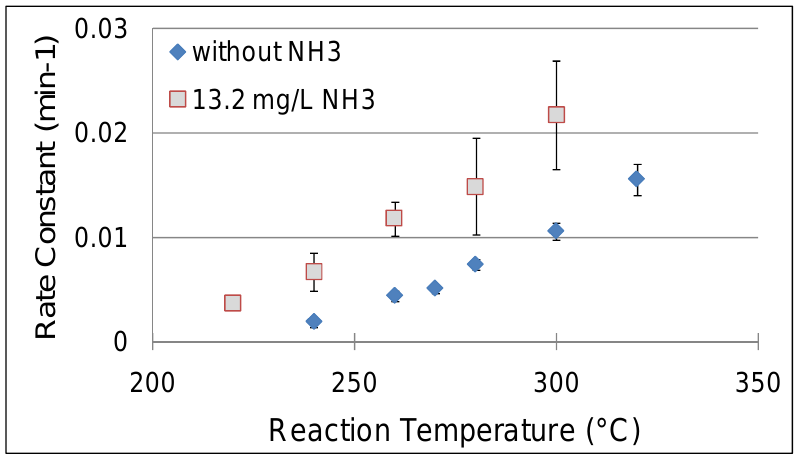
Figure 17. Evaluated rate constants of cinnamaldehyde hydrolysis to benzaldehyde at different temperatures and NH concentrations [72]. 3